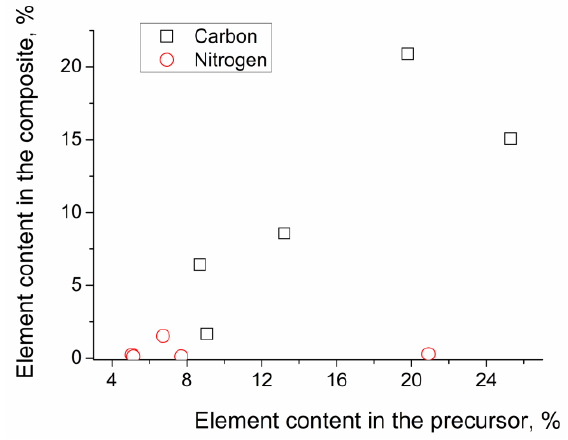
Figure 1. Content of C and N in the precursors before pyrolysis vs. content of these elements in the composites studied herein. Element content in the precursor was counted as weight of C in Im, Phen, DAB or Mel divided by summary weight of the anhydrous compounds multiplied by 100%, i.e., 100% × m(C org )/{m(Co(CH 3 CO 2 ) 2 ) + m(organic compounds) + m(SiO 2 )}.